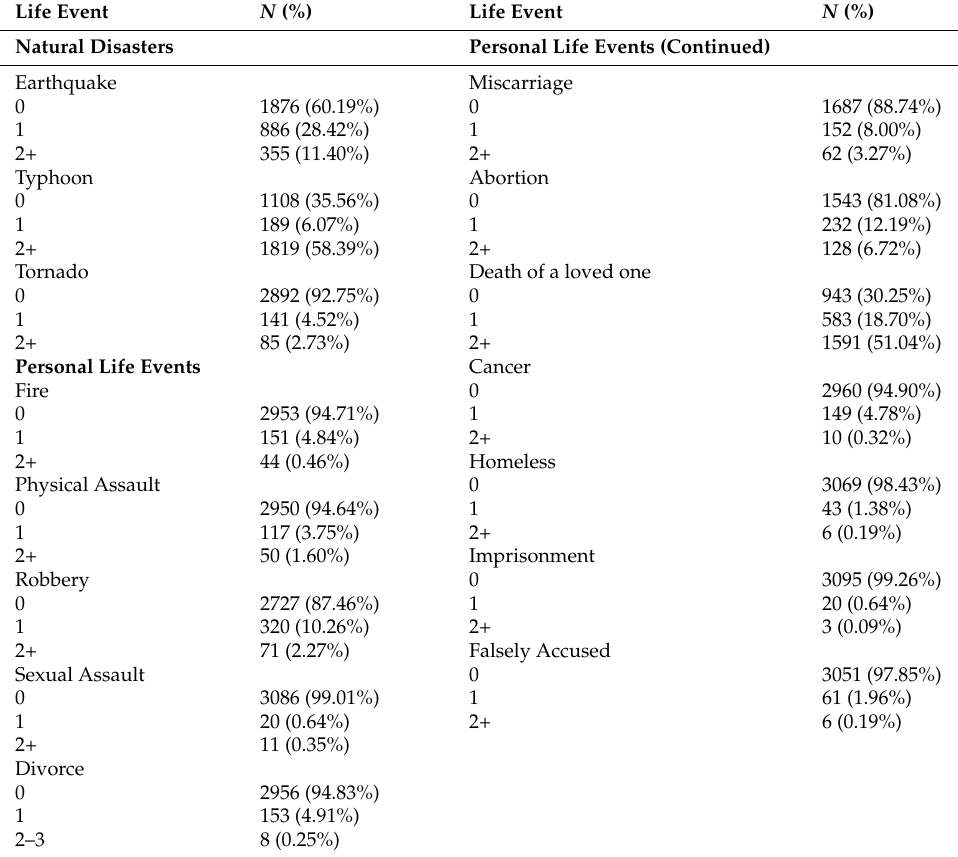
Table 2. Frequency of life events ( N =